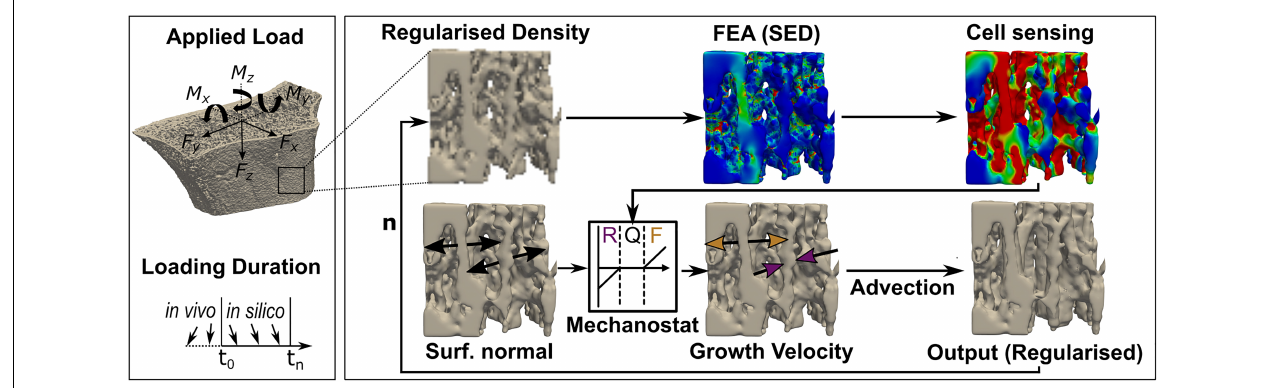
FIGURE 3 | Schematic workflow to derive bone geometries from advection-based remodelling simulations. Input, greyscale high-resolution peripheral quantitative computed tomography (HR-pQCT) images of the distal radius were first Gauss-filtered and regularised before finite element modelling. Strain energy density (SED) was derived from a linear finite element analysis (FEA), and cell sensing was mimicked through mechanical signal dilation with a fixed radius of 50 µ m. Tissue was remodelled using a SED-dependent velocity of ± 8,000 µ m/year/MPa and a maximum velocity of ± 12 µ m/month in regions where SED exceeded or fell short of the average tissue load (0.02 MPa) by ± 2%, and the growth direction was simulated normal to the bone surface. An advection step performed the surface movement, either resorption (R, purple) or formation (F, yellow), and a remodelled output regularised image was derived. Quiescence (Q) was modelled as no surface movement. This process repeats with the regularised output image as input for the next iteration